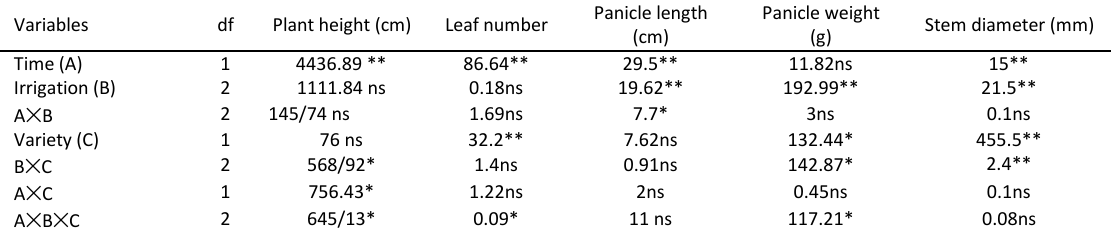
Table 1: Two-way ANOVA results of morphological variables of the two varieties of sorghum at different years under different irrigation levels Variables df